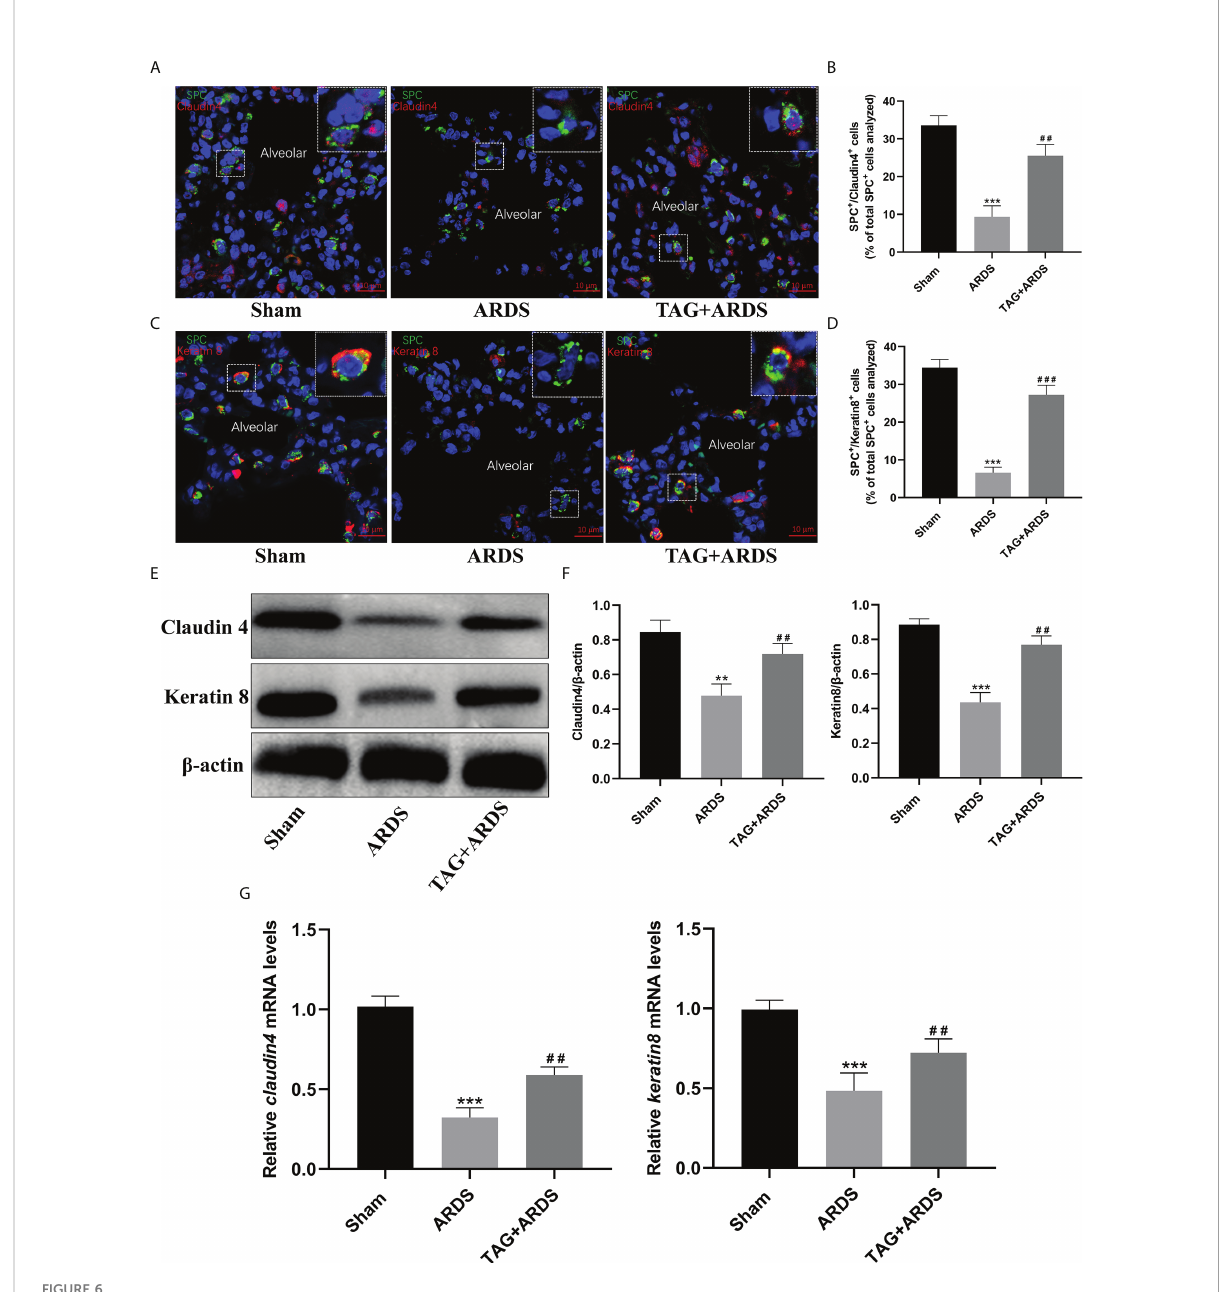
FIGURE 6 Effects of TAG on differentiation of alveolar type II cells under lung injury. (A – D) Representative immuno fl uorescence images of alveolar type II epithelial cells in the alveolar type II cells – alveolar type I cells transitional state (SPC + – Claudin 4 + and SPC + – Keratin 8 + ) across 3 experimental groups: Sham, ARDS, and TAG + ARDS (scale bar = 10 m m). The marker-positive cells were quanti fi ed with a confocal microscope. (E, F) Representative WB and quanti fi cation of Claudin 4 and Keratin 8 protein expression levels in each group. (G) RT-qPCR results show that the transcripts levels for claudin 4 and keratin 8 mRNA. Data are presented as mean ± SD. ** p < 0.01, *** p < 0.001, compared with the Sham group; ## p < 0.01, ### p < 0.001, compared with the ARDS group. TAG, D-tagatose; ARDS, acute respiratory distress syndrome; SPC, surfactant protein